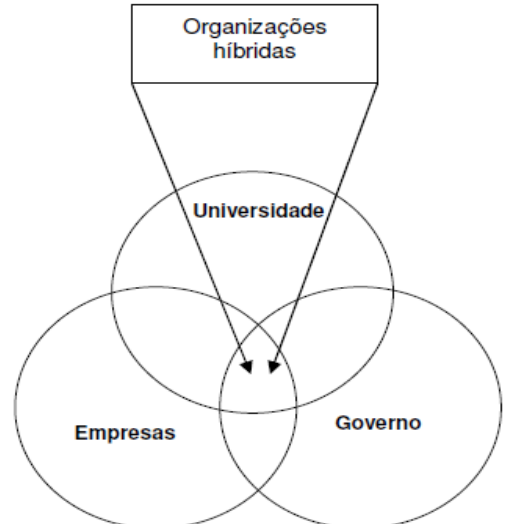
Figura 3. Modelo da hélice tríplice de relações